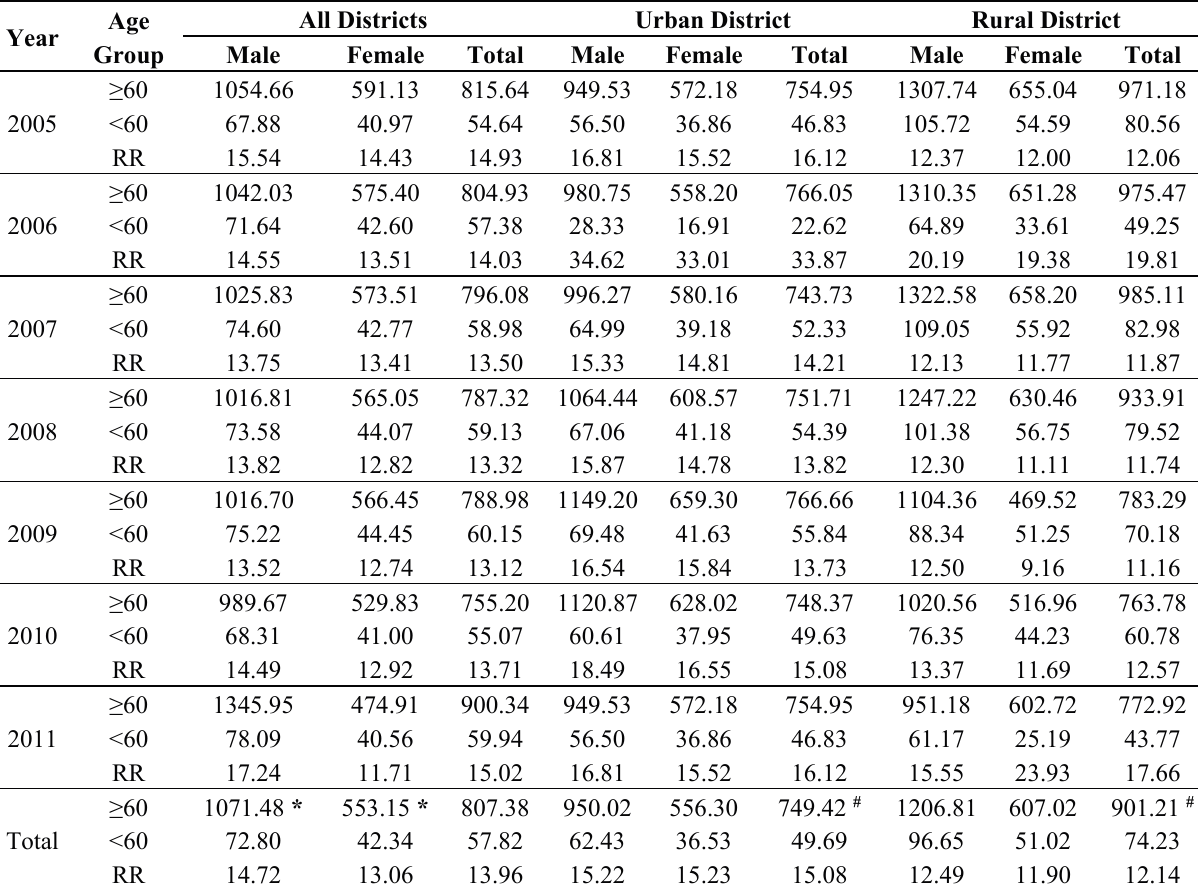
Table 3. Cancer-related mortality in the elderly ( ≥ 60 years) and young (<60 years) populations in China,